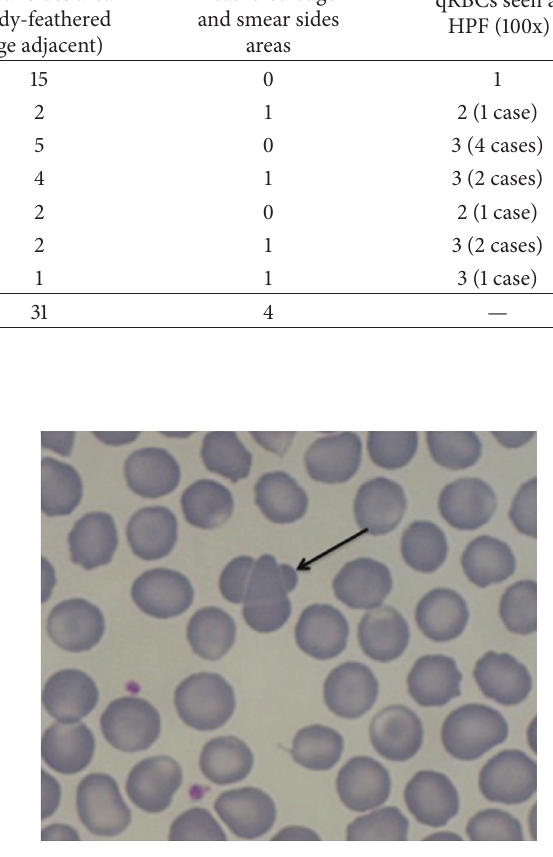
Figure 4: In this blood film at HPF (100x, May-Grundwald Giemsa) an intermediate form of qRBCs is easily seen (black